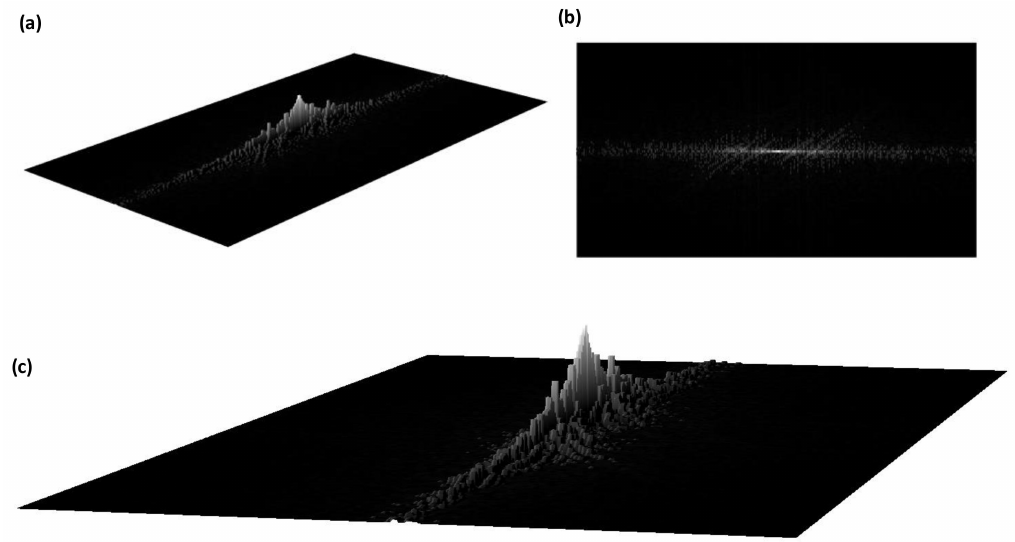
Figure 17. ( a – c ) DFT of the K-Means image: di ff erent perspectives of the 3D DFT processing of the inhomogeneous region highlighting amplitude